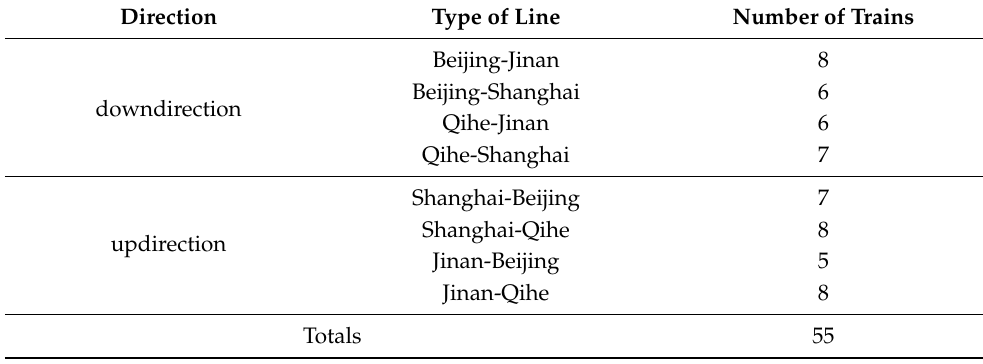
Table 4. Result of scenario 1.